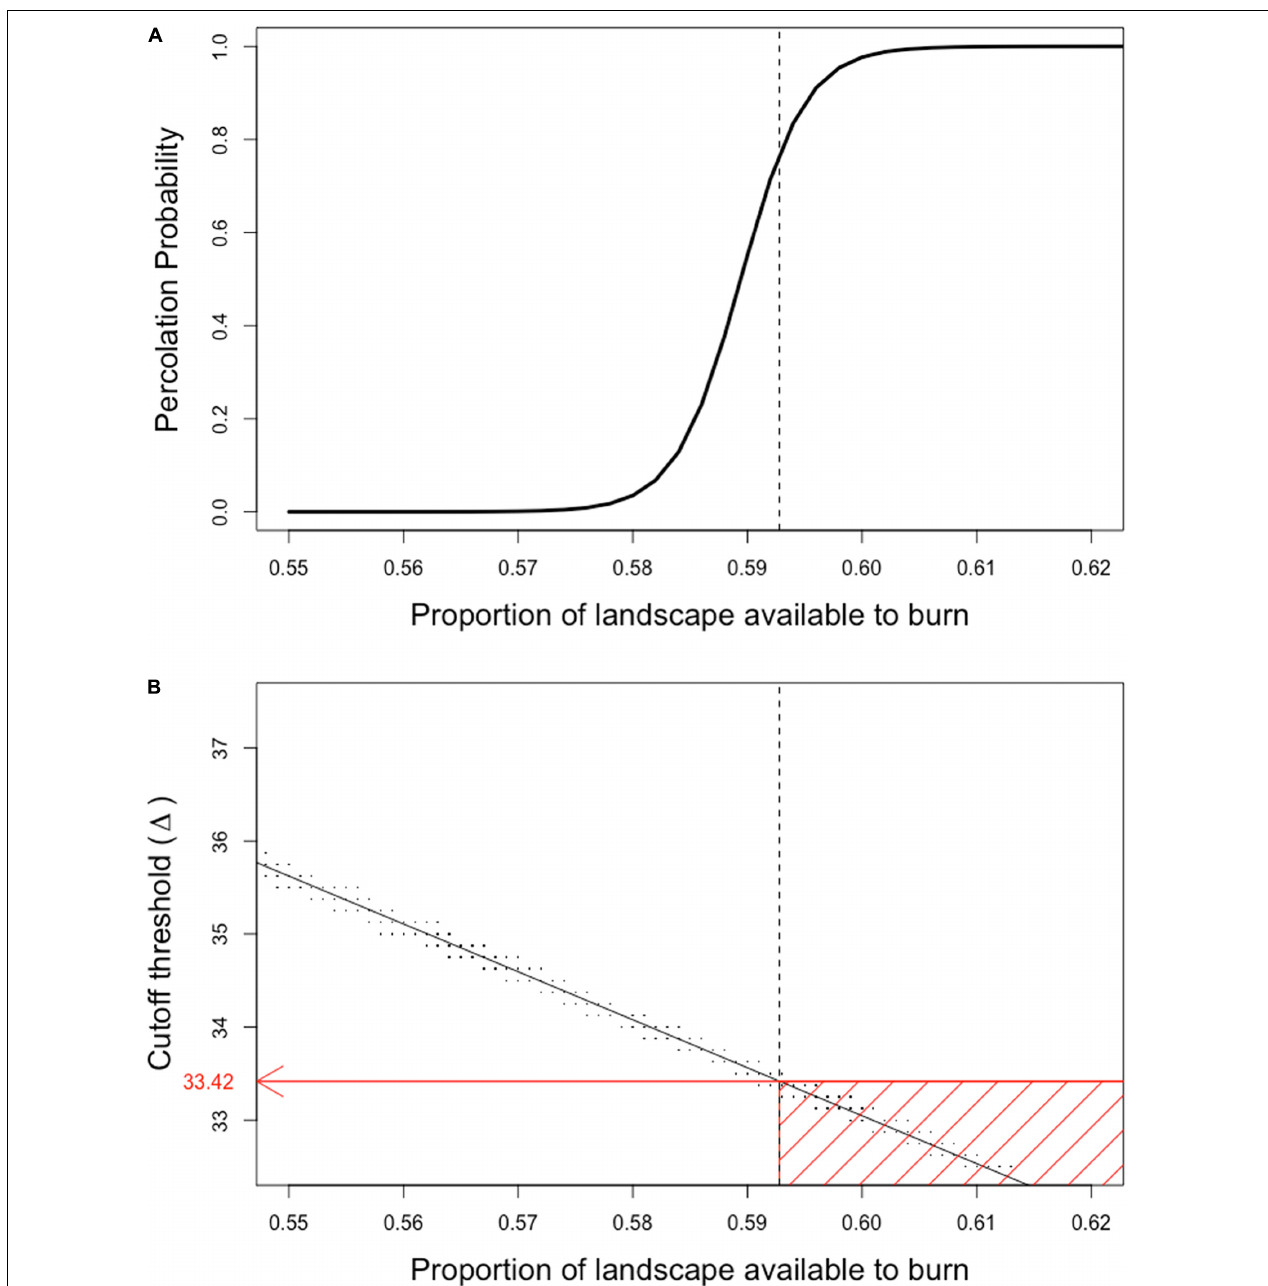
FIGURE 9 | Percolation probabilities and flammability of landscapes at different biomass thresholds of flammability. The proportion of landscape available to burn was the proportion of cells in the landscape that had biomass values at or above the flammability cutoff value (cid:49) . All replicates had randomly assigned biomass distributions based on the biomass levels found under the high precipitation (E), no burn (UB) and no disturbance (UT) treatment in matrix (OF) treatment sites in the Mojave site experiment using a gamma distribution fit to field data (see section “Materials and Methods” and Moloney et al., 2019). (A) Shows the percolation probability at varying levels of landscape flammability (Proportion of landscape available to burn, effectively the p cell value, was determined by calculating the proportion of cells with (cid:49) or greater biomass, which were the cells that could spread fire). The solid line is the percolation probability curve fit to the observed model output. The dotted vertical line is at p crit . (B) Shows the relationship between (cid:49) and the proportion of the underlying landscape that is available to burn (effectively the p cell value). Black dots represent the relationship between biomass cutoff values (cid:49) and the underlying proportion of the landscape that is flammable at that cutoff value for replicate model runs. The dotted vertical line is at p crit . The solid black line is the regression line of flammability threshold regressed on proportion of landscape available to burn. The horizontal red line is the biomass cutoff value that produces a landscape that has a proportion of burnable sites equal to p crit determined by assessing the regression at a value of p crit ; this value can also be obtained directly from the probability density function associated with the gamma distribution used in producing the landscape ( cf , the entry in Table 2 for Mojave, 2013). The red box encompasses the range of conditions that will produce a landscape that will be guaranteed to percolate.